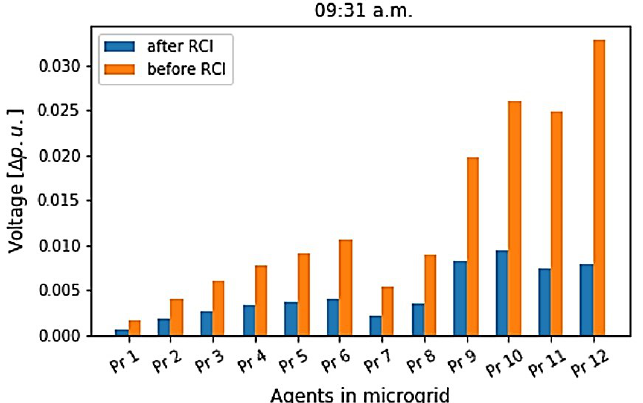
Figure 5. Voltage difference surpassing 1.0 p.u. at each prosumer bus at time step 09:31 a.m.